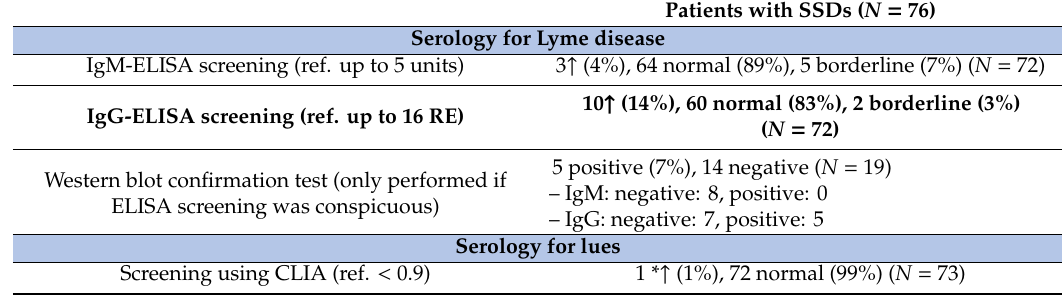
Table 5. Pathogen diagnostics in patients with schizophrenia spectrum disorders (SSDs). Values with alterations in > 10% are marked in bold. * Activity parameters were